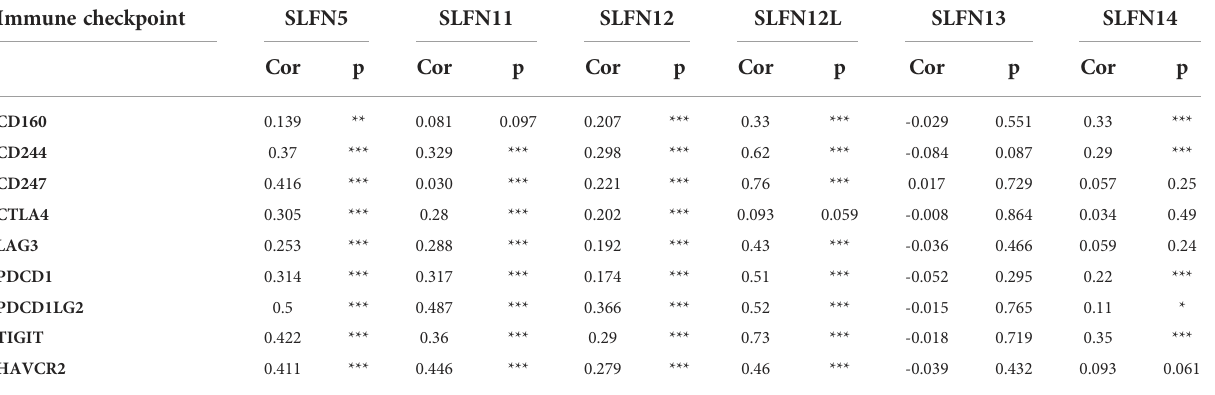
TABLE 3 Correlation between SLFN and immune checkpoint. Immune